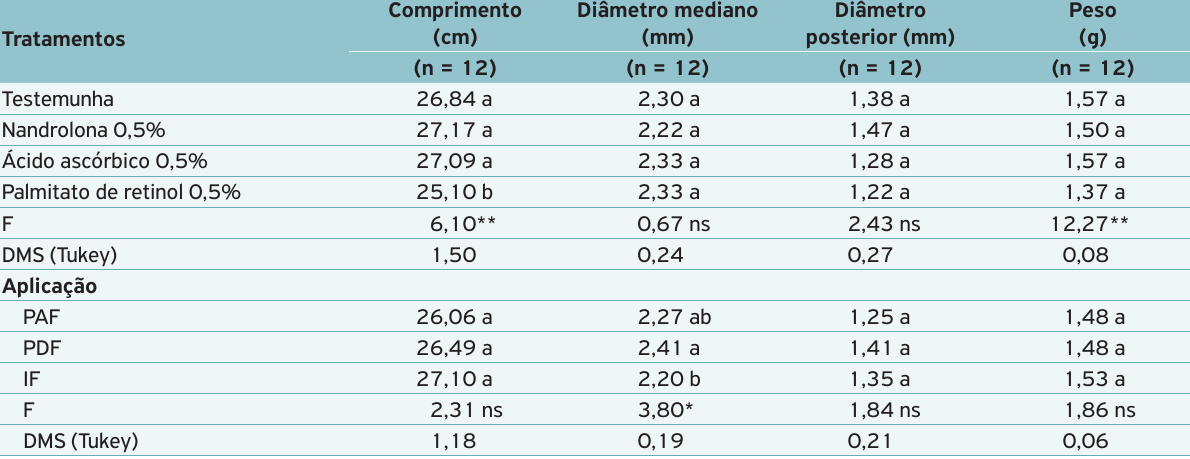
Tabela 2. Comprimento médio (cm), diâmetro médio (mm) das porções mediana e posterior e peso médio (g) da glândula